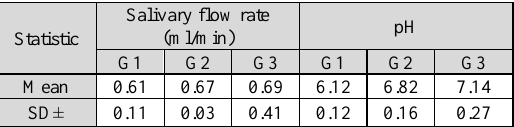
Table (6): Inter group comparison of mean of salivary flow rate and salivary pH between